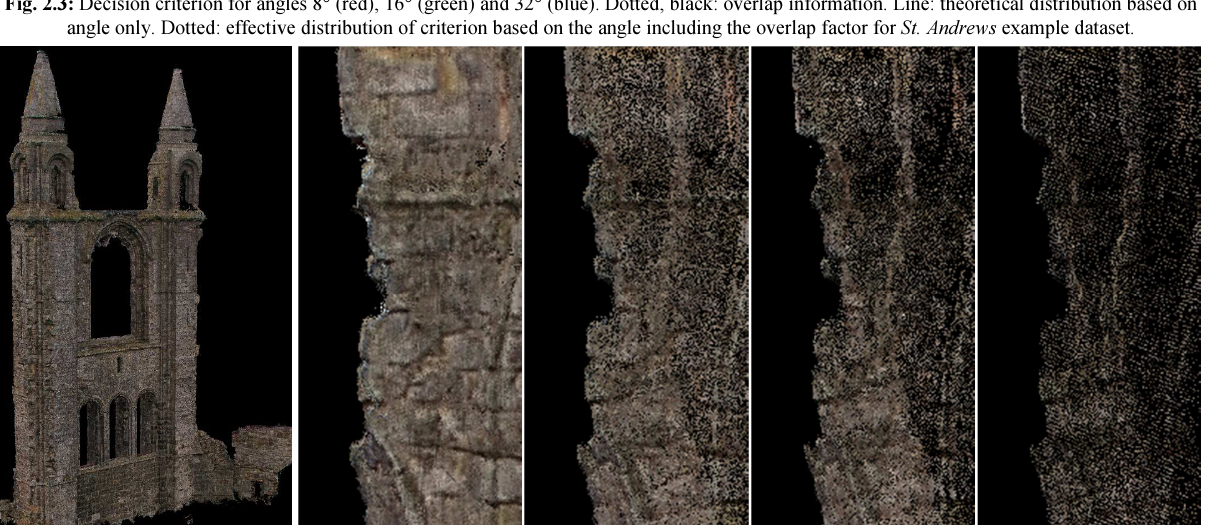
Fig. 2.2: Normalized overlap, mean angle and decision on the St. Andrews dataset for µ=[8°,8°,16°,16°,32°,32°]